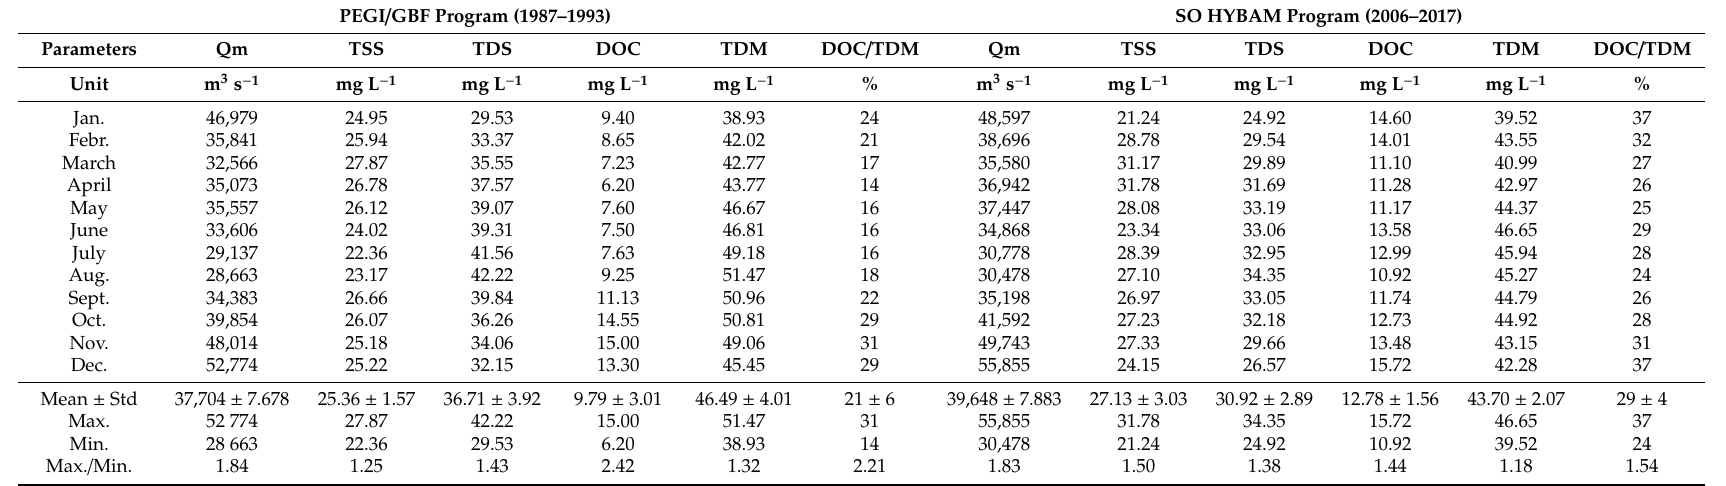
Table 2. Interannual monthly discharges (Qm) and interannual monthly concentrations of total suspended sediment (TSS), total dissolved solid (TDS), dissolved organic carbon, total dissolved matter (TDM = TDS + DOC) and DOC / TDM percentage, at the Congo River Outlet, respectively, calculated for the two studied periods (1987–1993 and